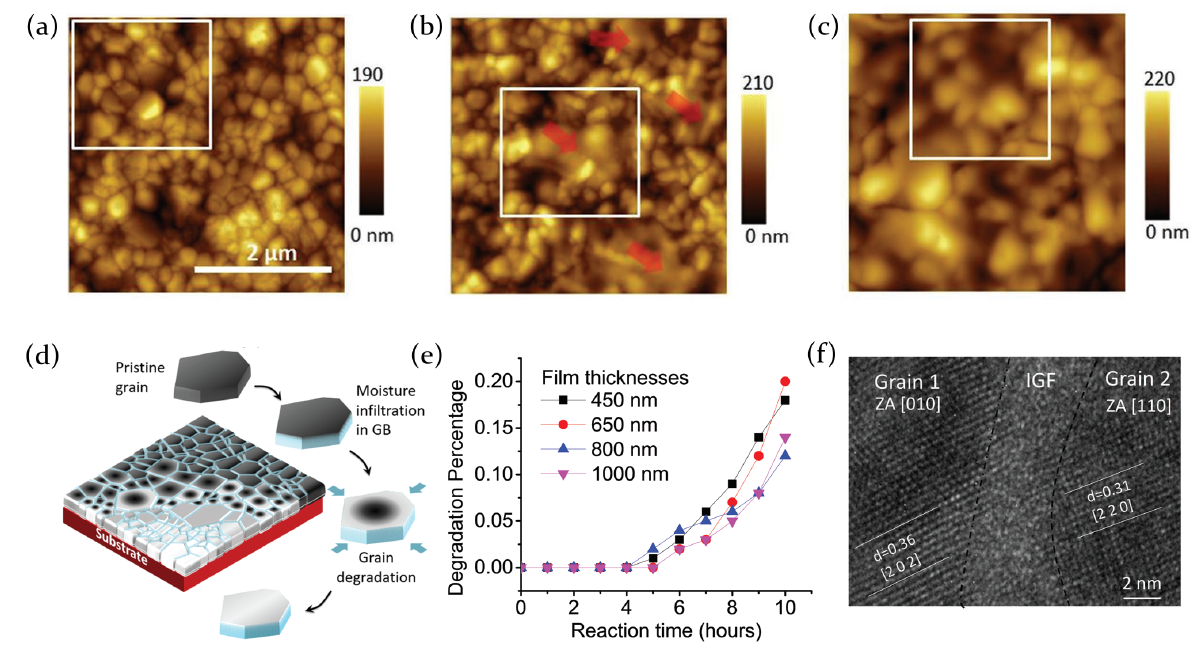
Figure 6. ( a – c ) AFM images of FAPbI 3 film, showing the different stages of the degradation process, from the fresh sample (dark black film) to the degraded one (pale yellow). Adapted with permission from [68]. Copyright 2018, WILEY-VCH Verlag GmbH and Co. KGaA, Weinheim. ( d ) Schematic representation of the degradation of MAPbI 3 perovskite film in moisture; the degradation mechanism starts from grain boundaries and extends towards the grain center along the in-plane direction. ( e ) Degradation percentage as a function of the moisture exposure time for different film thicknesses. ( f ) A HRTEM cross-sectional image highlighting the presence of an intergranular film (IGF) between two neighboring grains. Republished with permission of the Royal Society of Chemistry, from [67], ©